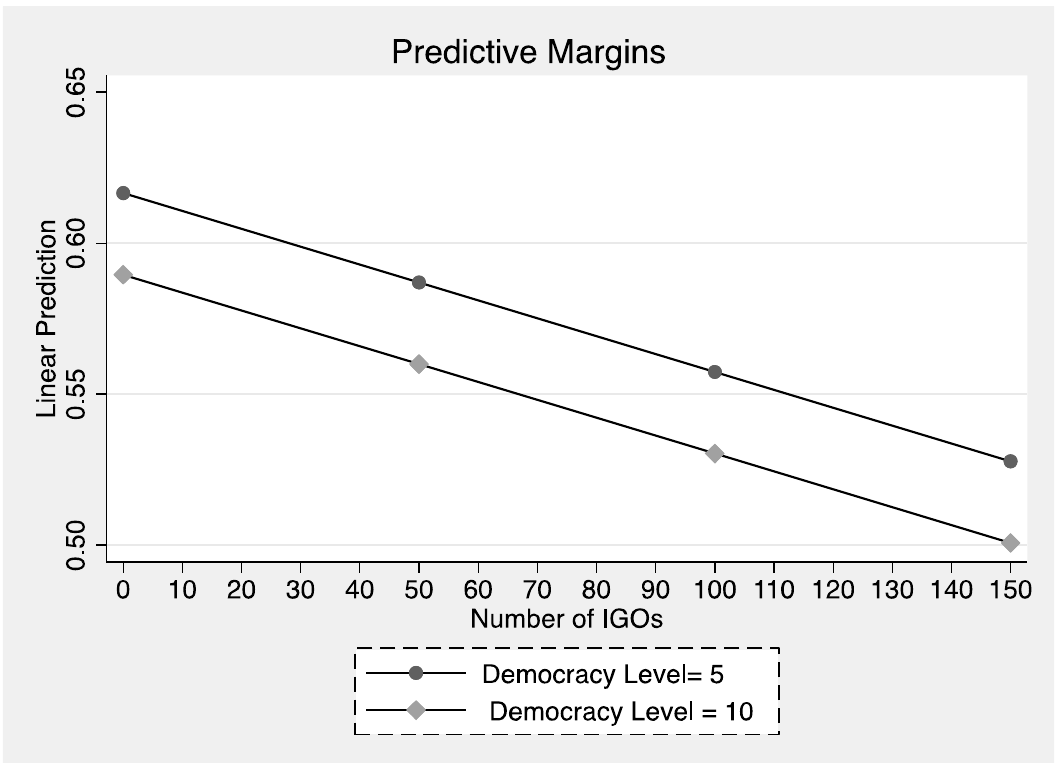
Figure 1. Fitted values of the quality of government index and democracy. Note: The dependent variable, The quality of government index, ranges from ZERO to ONE. Higher scores indicate better government performance. In our sample, the mean of the quality of government index is 0.56; SD = 0.23. The mean number of IGOs in which a country participated during the time period of our analysis is 49 (SD = 23.6).